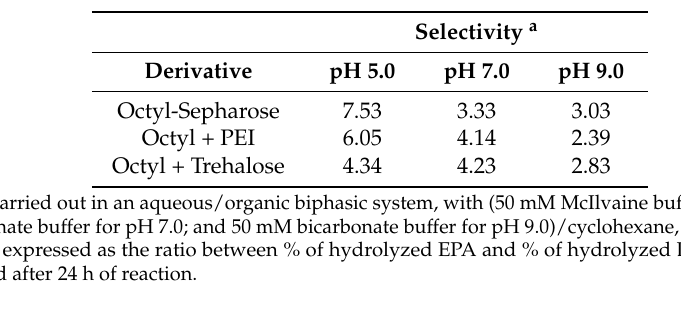
Parameters of fish oil hydrolysis with M. spathulata R25L270 lipase immobilized